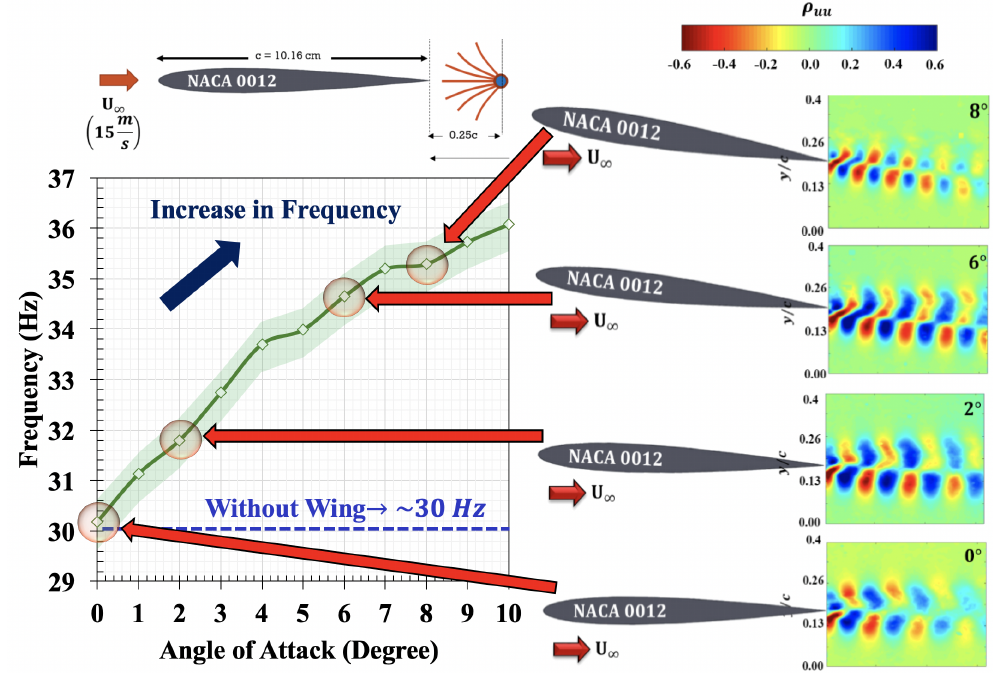
Figure 16. Variation of PVDF oscillation frequency with angle of attack due to increase in coherent structures in the wake of NACA 0012